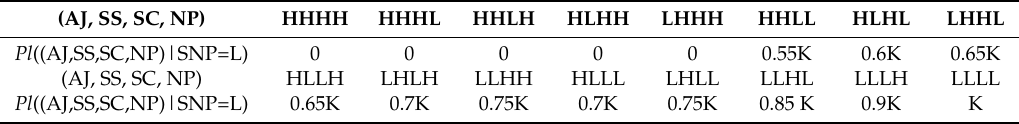
Table 7. The reverse conditional likelihood